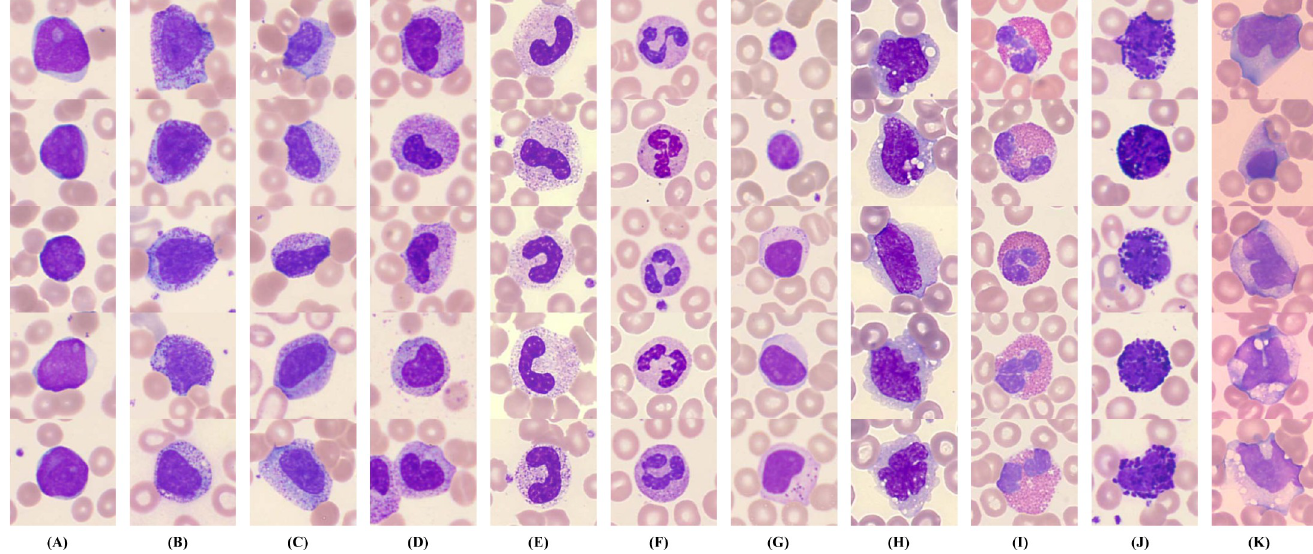
PLOS ONE | https://doi.org/10.1371/journal.pone.0218808 June 25,